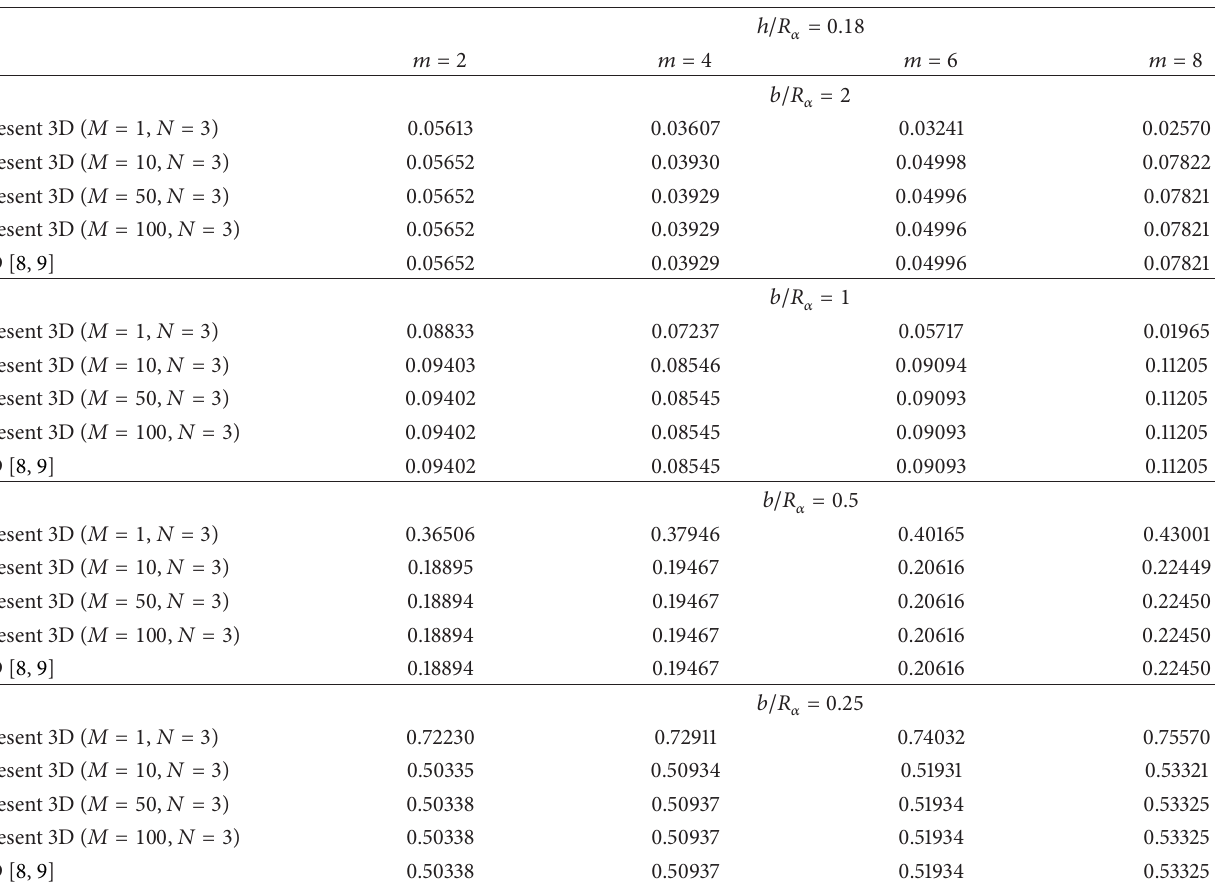
Table 3: Assessment 2 (part II). Simply supported aluminum cylinder with Poisson ratio ] = 0.3 and thickness ratio ℎ/𝑅 𝛼 = 0.18 . Lowest exact natural circular frequencies in no-dimensional form 𝜔 = 𝜔(ℎ/𝜋)√𝜌/𝐺 for imposed axial half-wave number 𝑛 = 1 and several half- wave numbers 𝑚 in circumferential direction. Comparison between present three-dimensional analysis and three-dimensional analysis by Armenakas et al. [8] as adapted in Bhimaraddi [9]. 𝑀 is the number of fictitious layers and 𝑁 is the order of expansion for the exponential